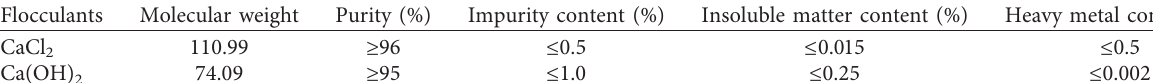
Table 2: Basic properties of flocculants.